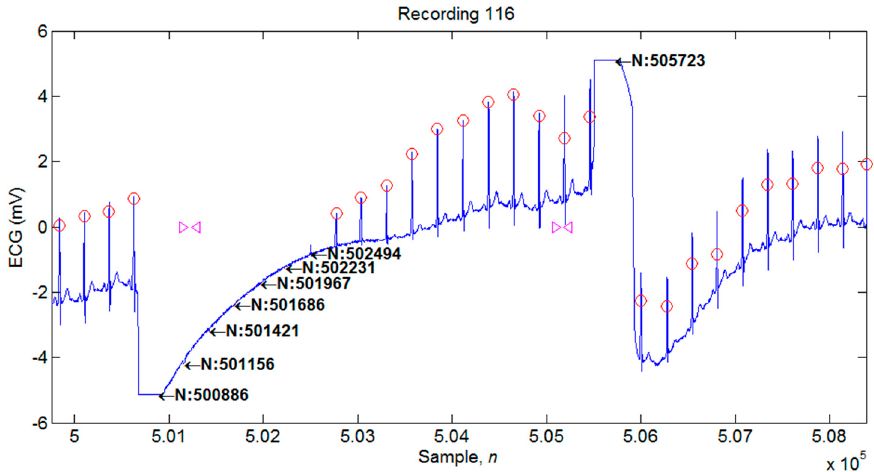
Figure 16. Illustration of the detection failures caused by the P-peak being sharper than the QRS peak.